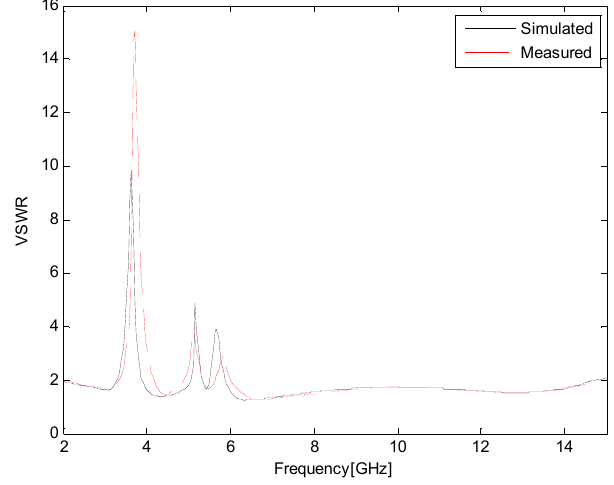
Sensors 2017 , 17 , 349 Figure 10. Photos of the fabricated triple band-notched UWB antenna: ( a ) front view; ( b ) back view.